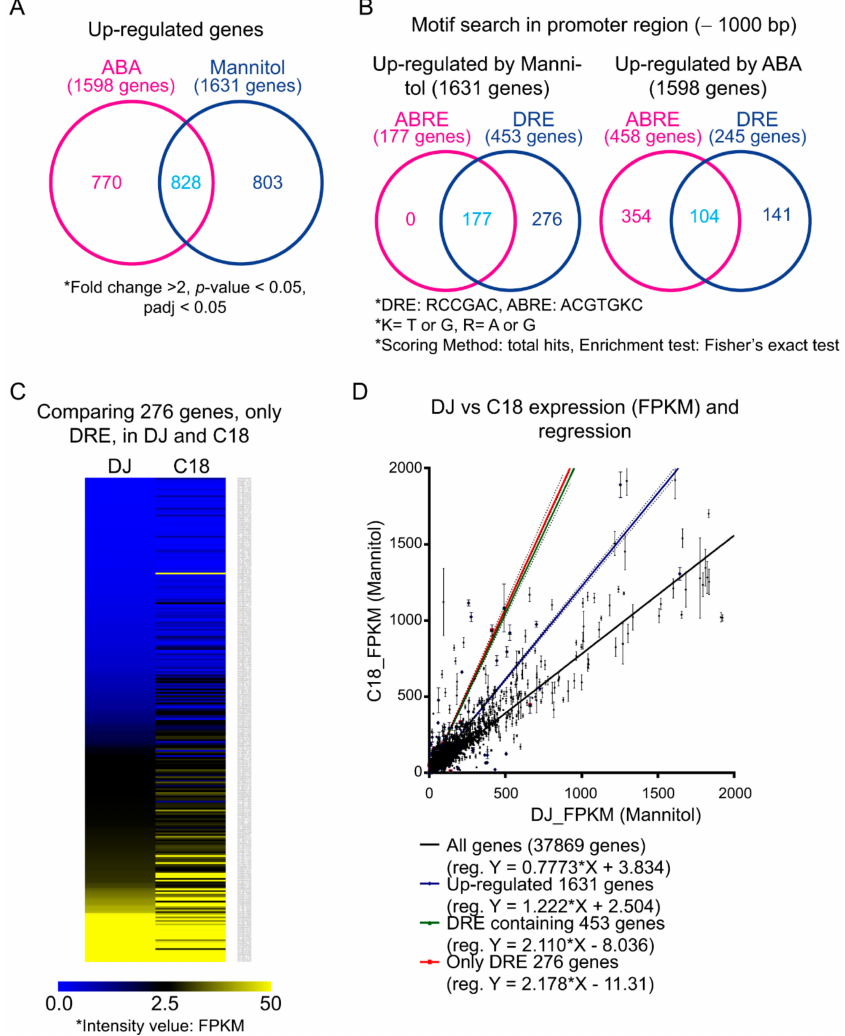
Figure 5. Transcriptome and promoter motif analysis in response to mannitol or ABA treatment. ( A ), Venn diagram of upregulated genes after treatment with 200 mM mannitol or 10 µ M ABA. The genes were selected with the indicated criteria (fold-change > 2, p -value and padj < 0.05). ( B ), Venn diagrams of genes whose promoters contain DRE and/or ABRE cis -acting elements. We performed an AME analysis on the MEME website. Venn diagrams were generated with InteractiVenn (http:// interactivenn.net). ( C ), Heatmap of FPKM values for 276 genes containing cis -DRE. ( D ), Comparison of FPKMs for the indicated genes between wild-type (DJ) and C18 seedlings treated with 200 mM mannitol. Dotted line: slope of 1. The values are FPKM ± SD ( n =